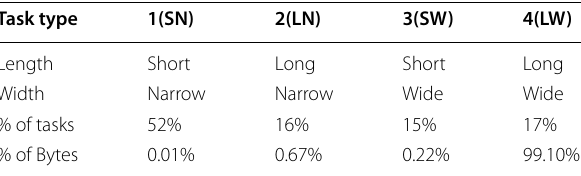
Table 2 Typical traffic characteristics of tasks in the data center